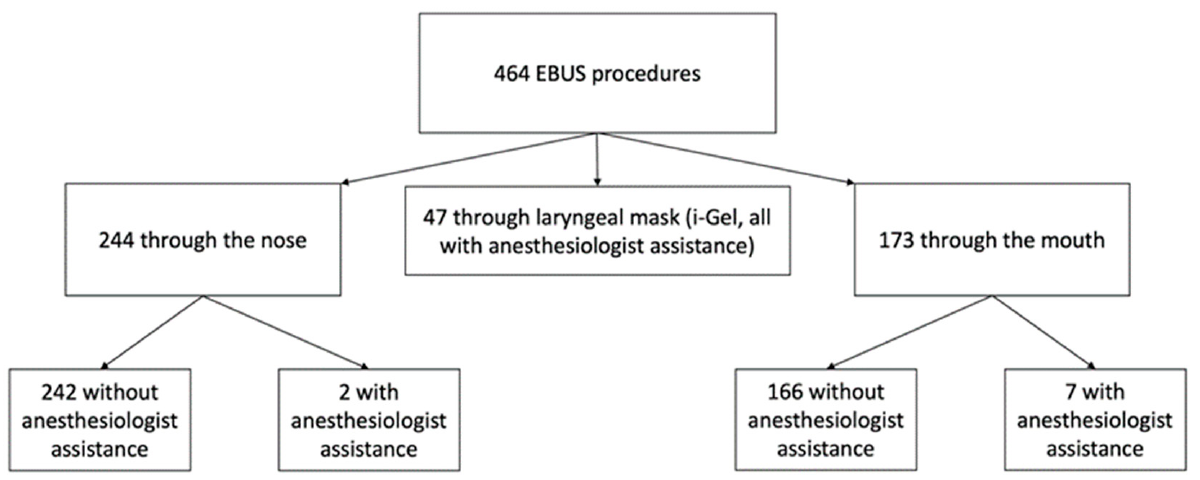
Figure 2. Division of the casuistry based on the entry way of the EBUS scope and anesthesiologist assistance. EBUS, endobronchial ultrasound.